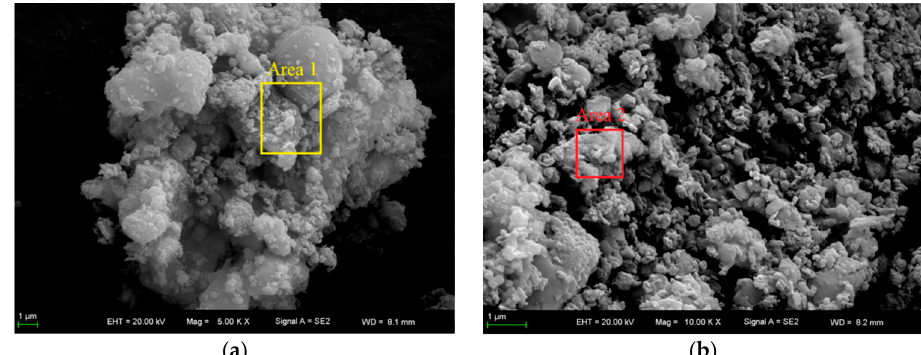
Figure 11. SEM images of high-sulfur bauxite ( a ) before and ( b ) after calcination.